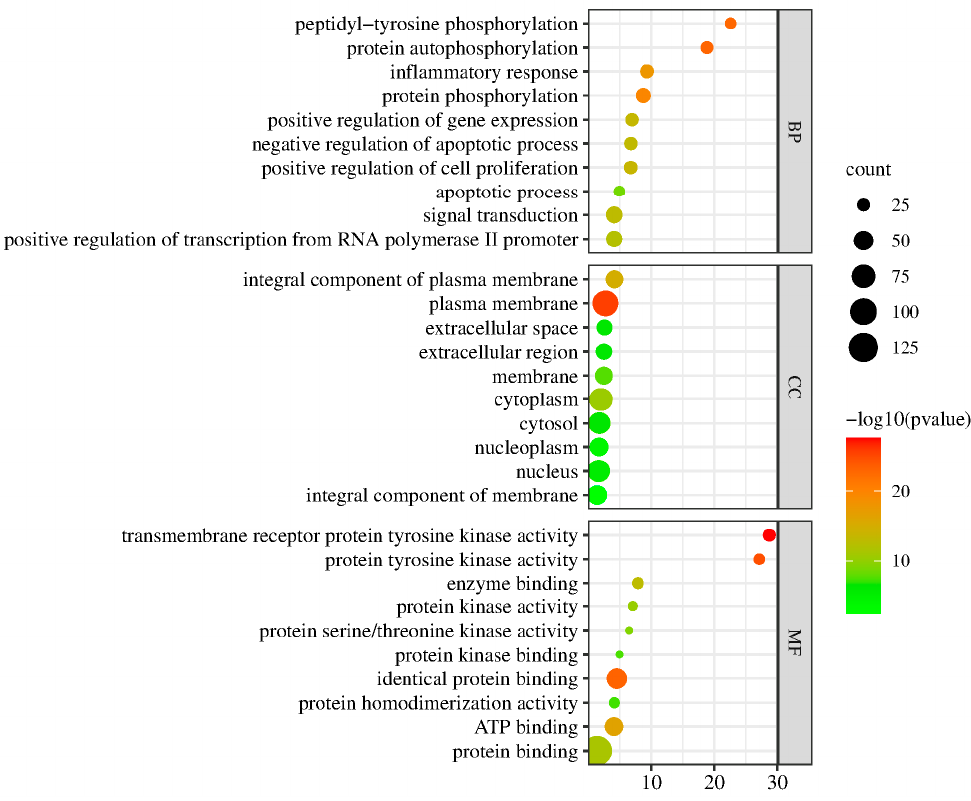
Figure 8. The top 10 GO functional terms of 141 intersection targets. Table 2. Molecular docking results of active components and target genes of